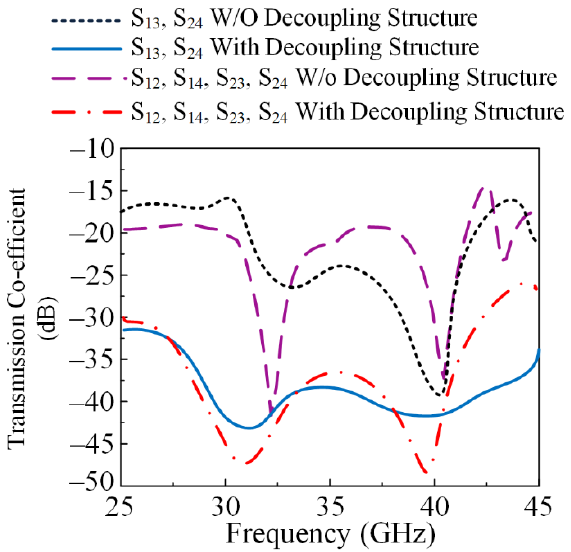
Figure 8. Comparison plot of transmission coefficient with and without parasitic element.